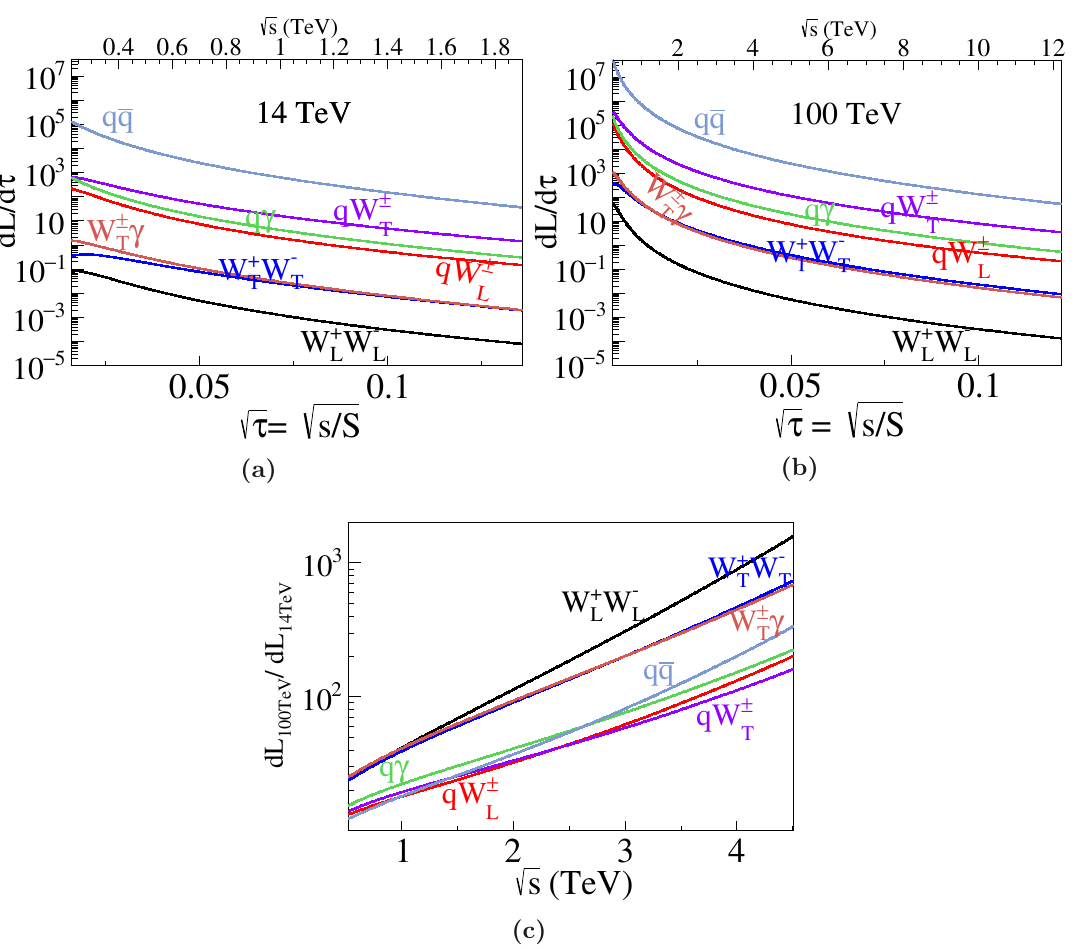
Figure 3. Representative parton luminosities in pp collisions at (a) √ S = 14 TeV, (b) √ S = 100 TeV, and (c) the ratio of luminosities between the two beam energies as a function of partonic CM energy √ s